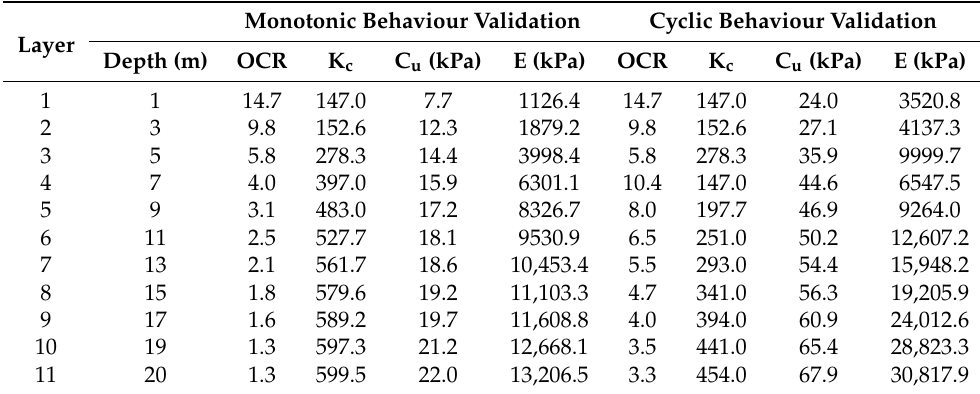
Table 8. Input soil properties for validating the monotonic and cyclic behaviour (after [16]). Monotonic Behaviour Validation Cyclic Behaviour Layer